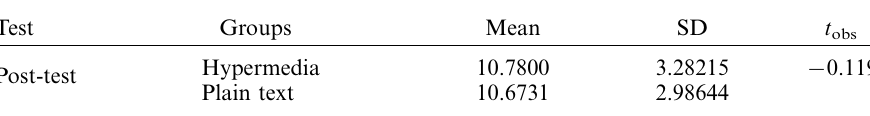
Table 4. Results for